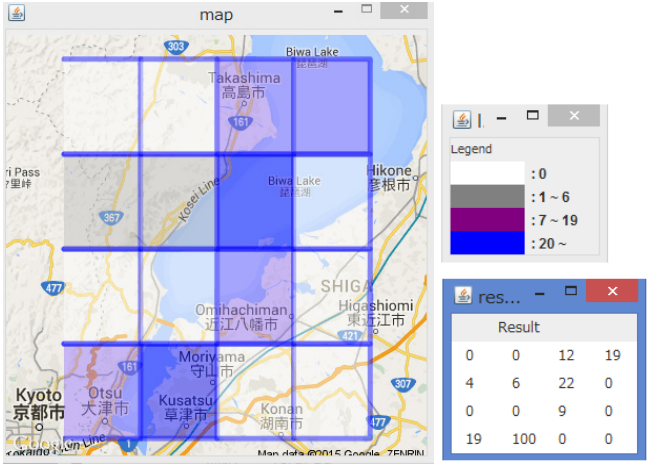
Fig. 12. An example of a distribution map created. The map used is taken from Google